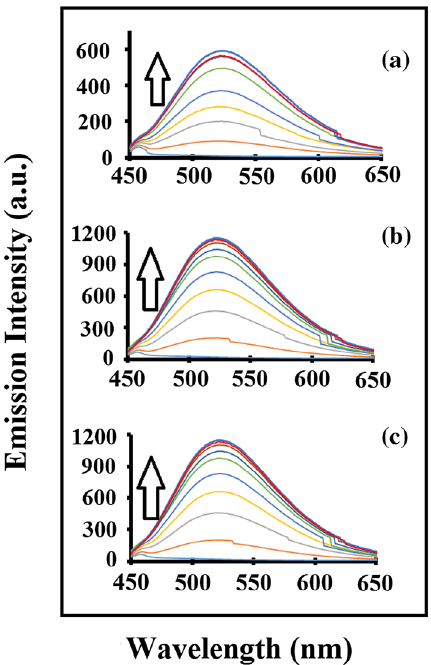
Figure 4. Changes in the fluorescence emission spectra ( a–c ) for compound 4–6 (1 × 10 –4 mol L –1 ) in acetonitrile respectively upon incremental addition of TBAF (10 equiv) (λ ex = 403 nm).